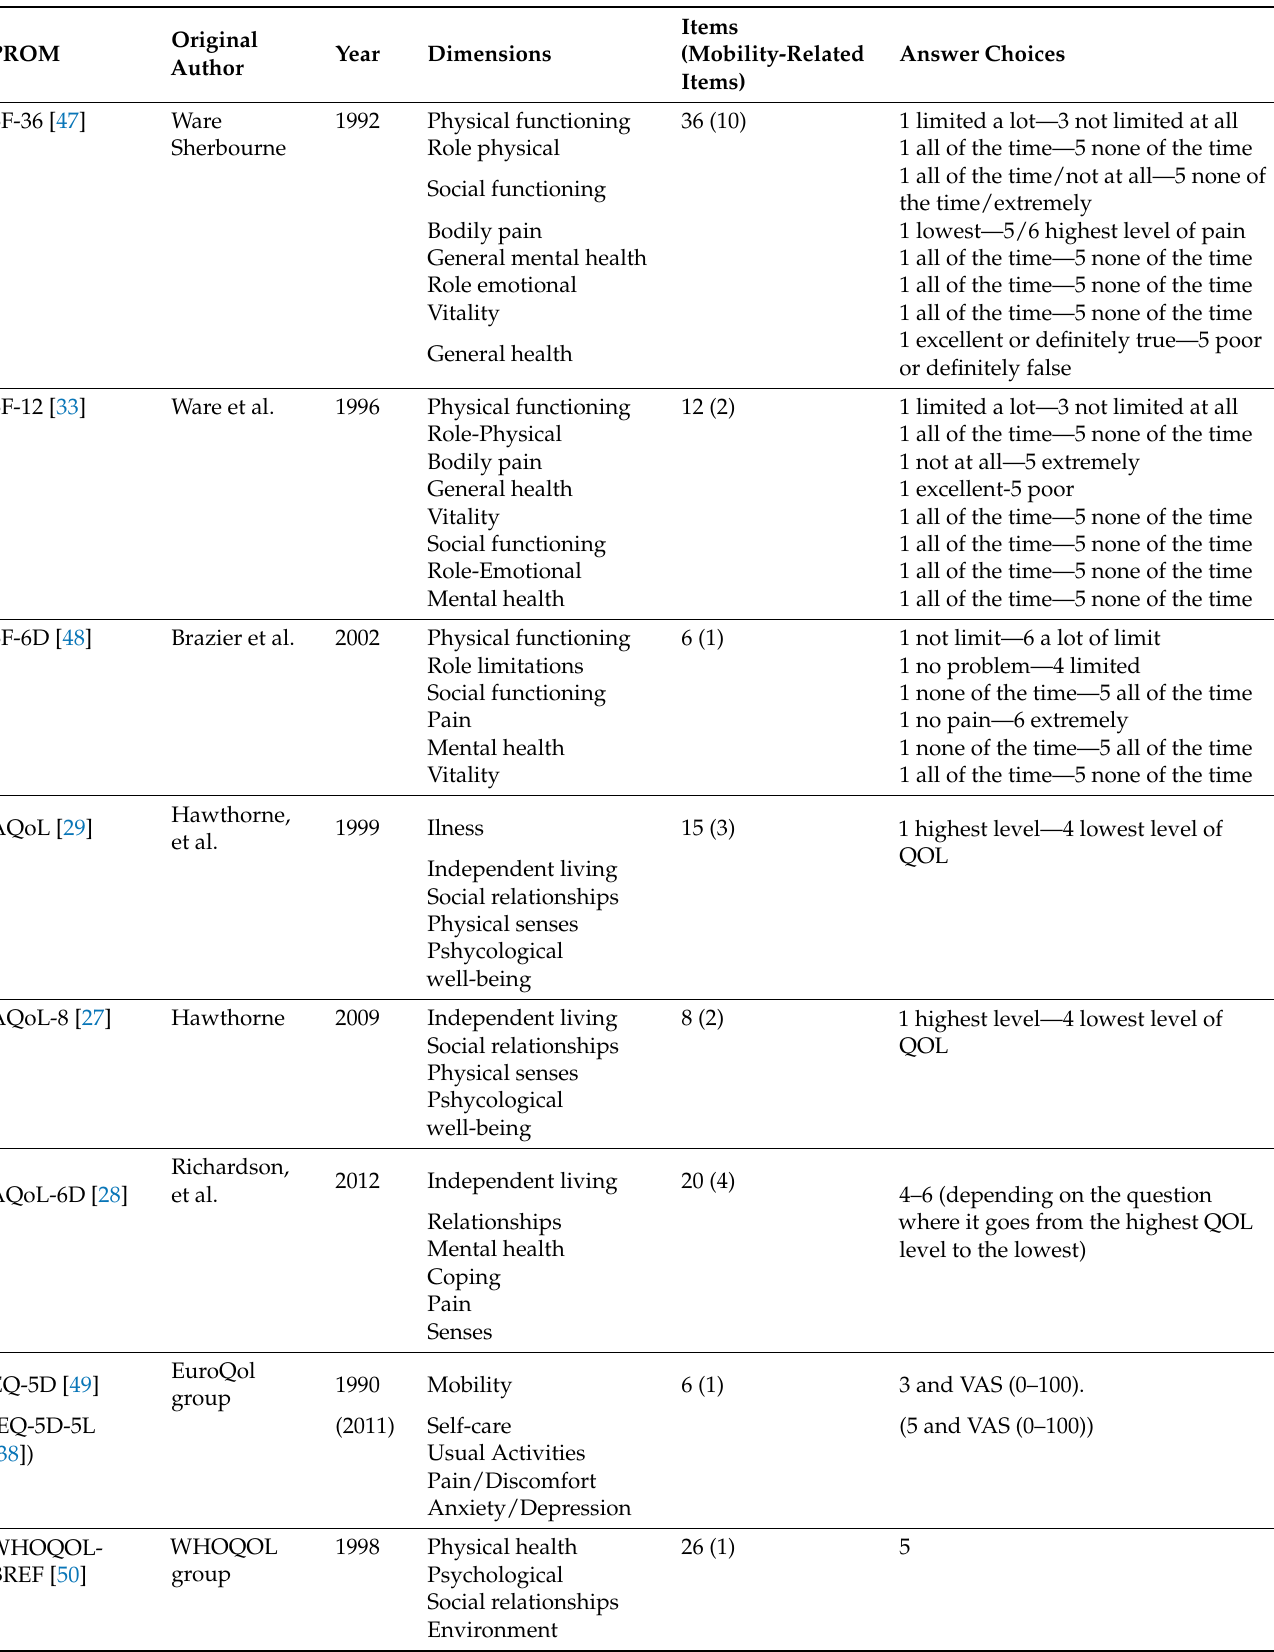
Table 2. Characteristics of the general HRQOL instruments included in the